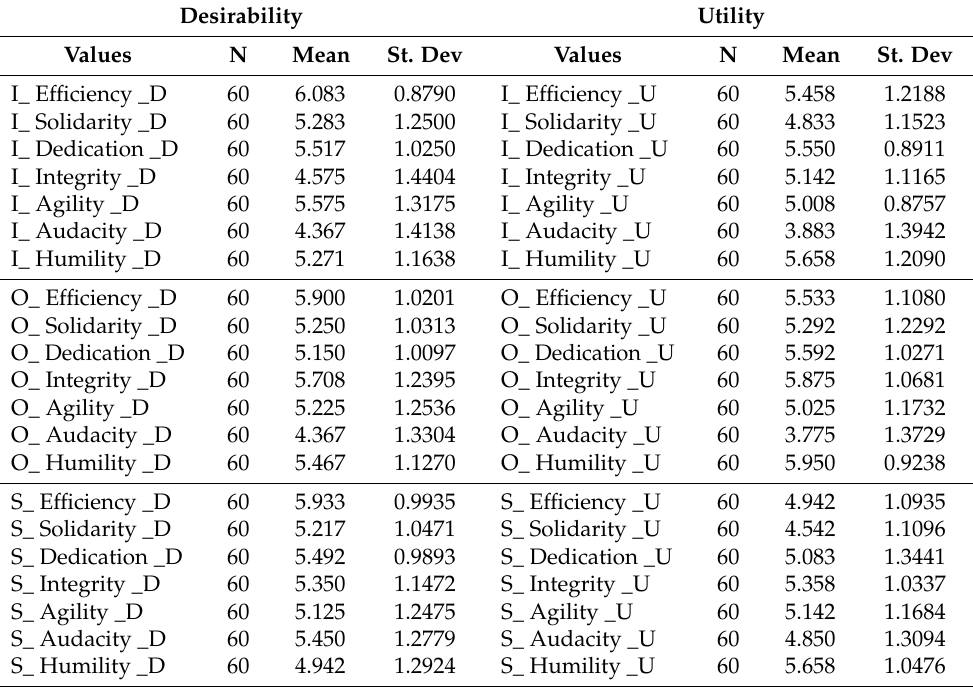
Table A2. Mean and standard deviation for social desirability and social utility of the traits